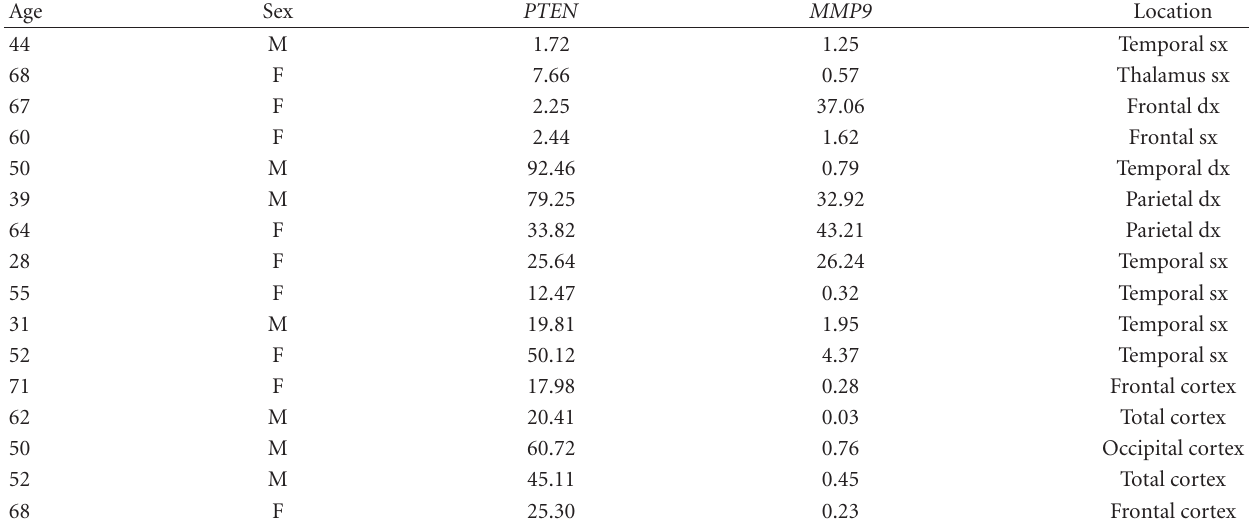
Table 2: Age, gender, PTEN , and MMP9 expression values (in femtograms), and anatomical location of anaplastic astrocytoma samples.